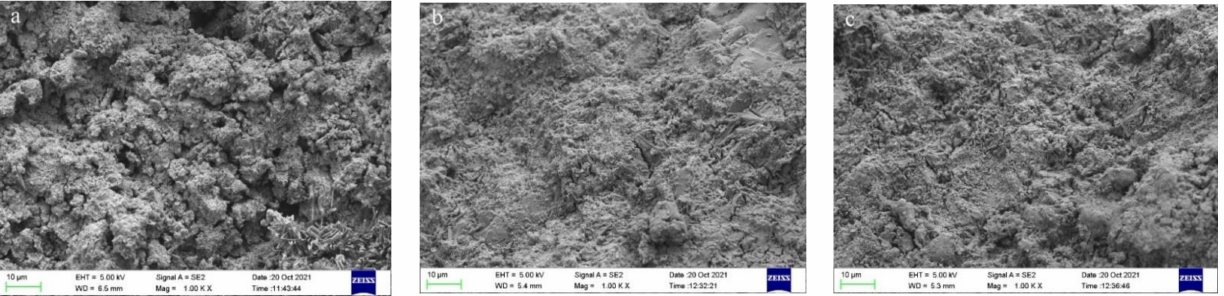
Figure 7. SEM images of non-fired bricks under different forming pressures: ( a ) 9 MPa; ( b ) 18 MPa; ( c ) 21